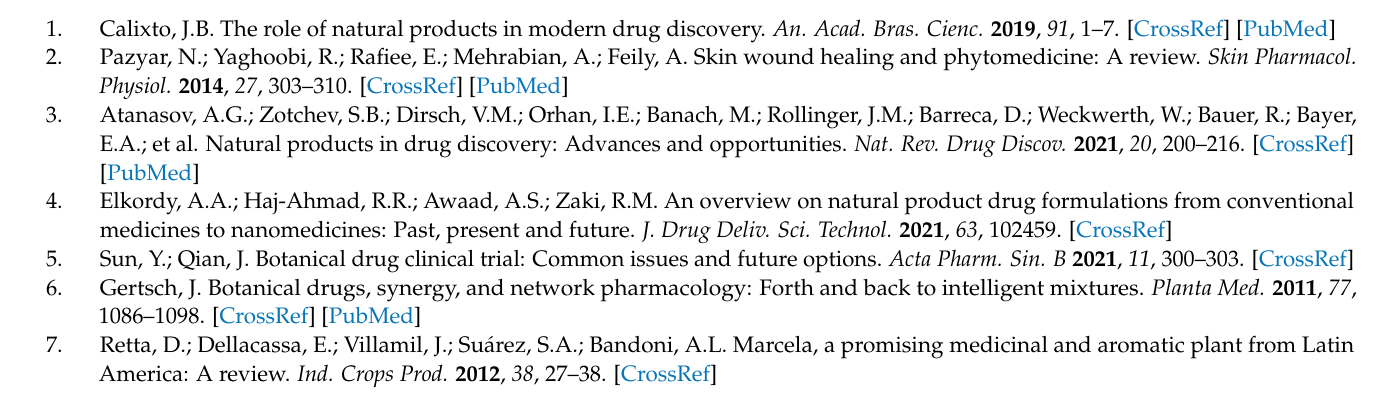
Olive oil ASE:Olive oil (1:100) w/v 0 (0) NE B 0